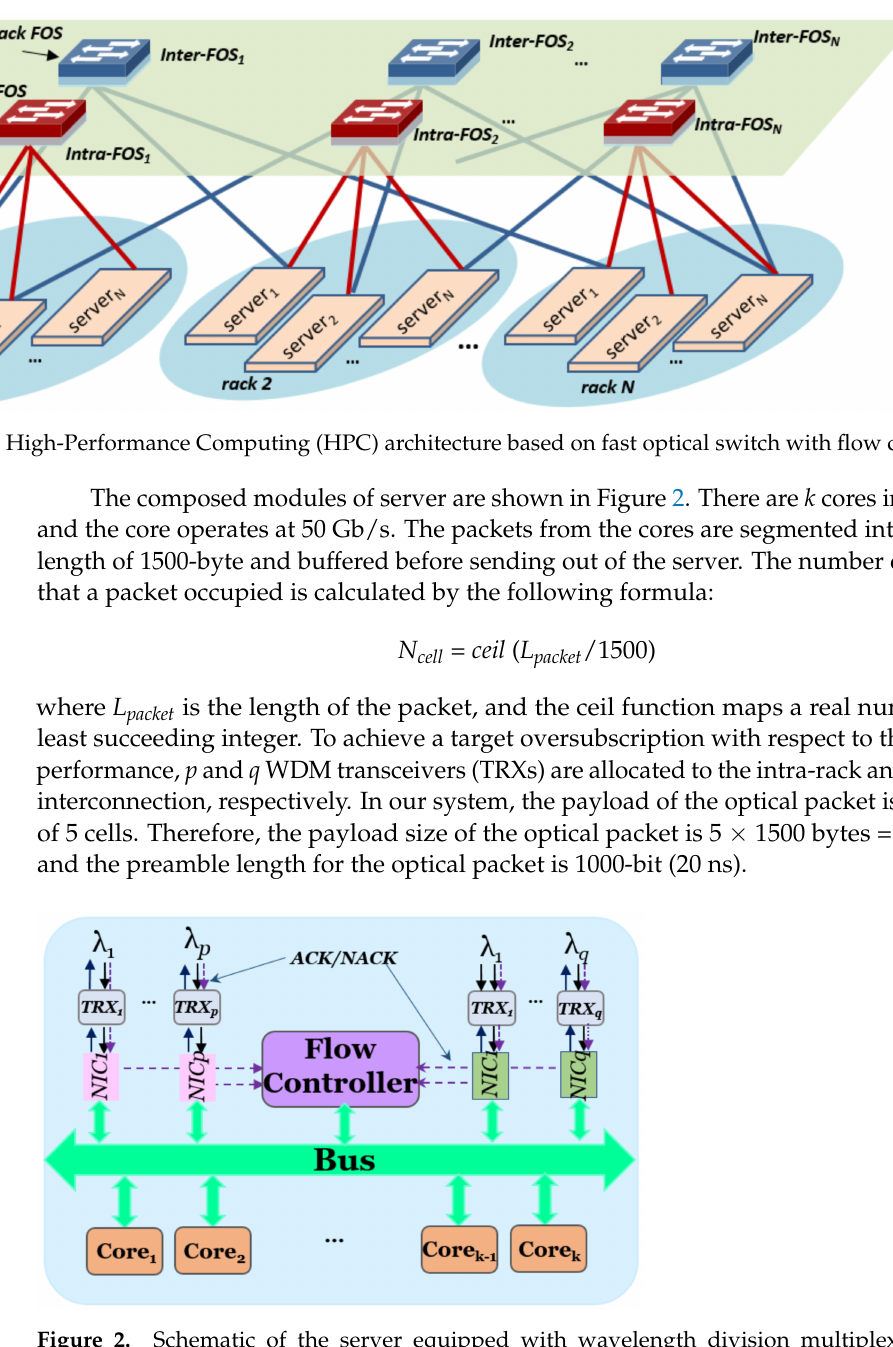
Figure 2. Schematic of the server equipped with wavelength division multiplexing (WDM) transceivers and fast flow